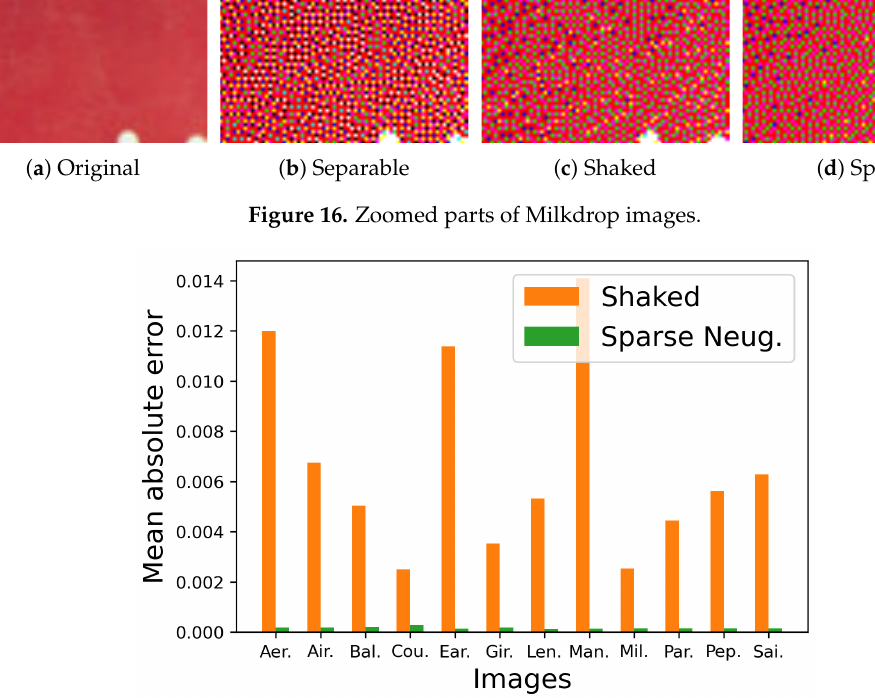
Figure 17. Mean absolute errors of halftoned SIDBA images in Figure